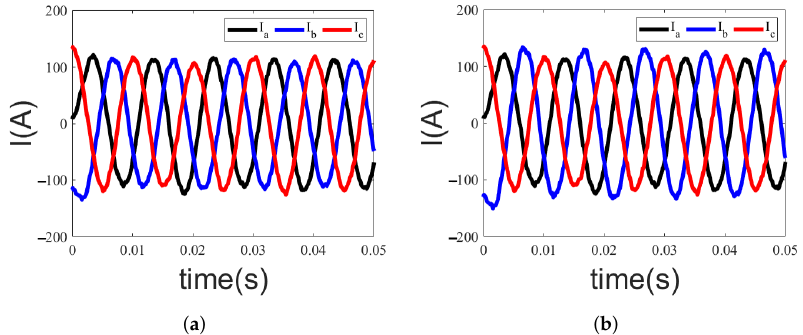
Figure 16. The current waveform when input voltage phase is imbalance ( a ) Input voltage amplitude is imbalanced when ITSC fault does not occur; ( b ) input voltage amplitude is imbalanced and µ = 0.1 in B